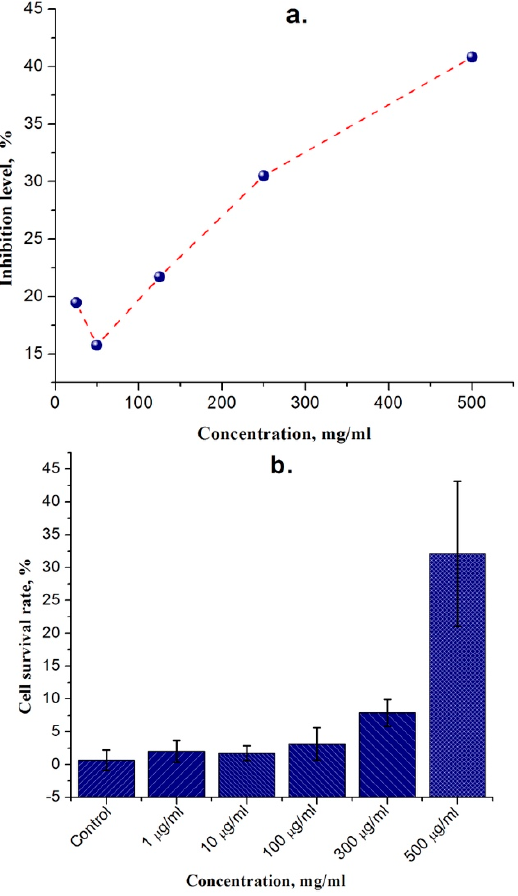
Figure 4. Antioxidation and cell viability tests. ( a ) Spondias mombin L. seed oil shows concentration- dependent antioxidant activity. It was measured by 2,2 ′ -Azino-bis (3-ethylbenzothiazoline-6-sulfonic acid) diammonium salt (ABTS) antioxidant activity assay incubated for 30 min. ( b ) Spondias mombin L. seed oil increases cell viability. HTC 116 cells were cultured and incubated with different concentrations of vegetable oil. After 24 h, a water-soluble tetrazolium salt (WST) assay showed the increase of cell viability according to oil concentration. Nontreated cells were used as control referring 100% viability.